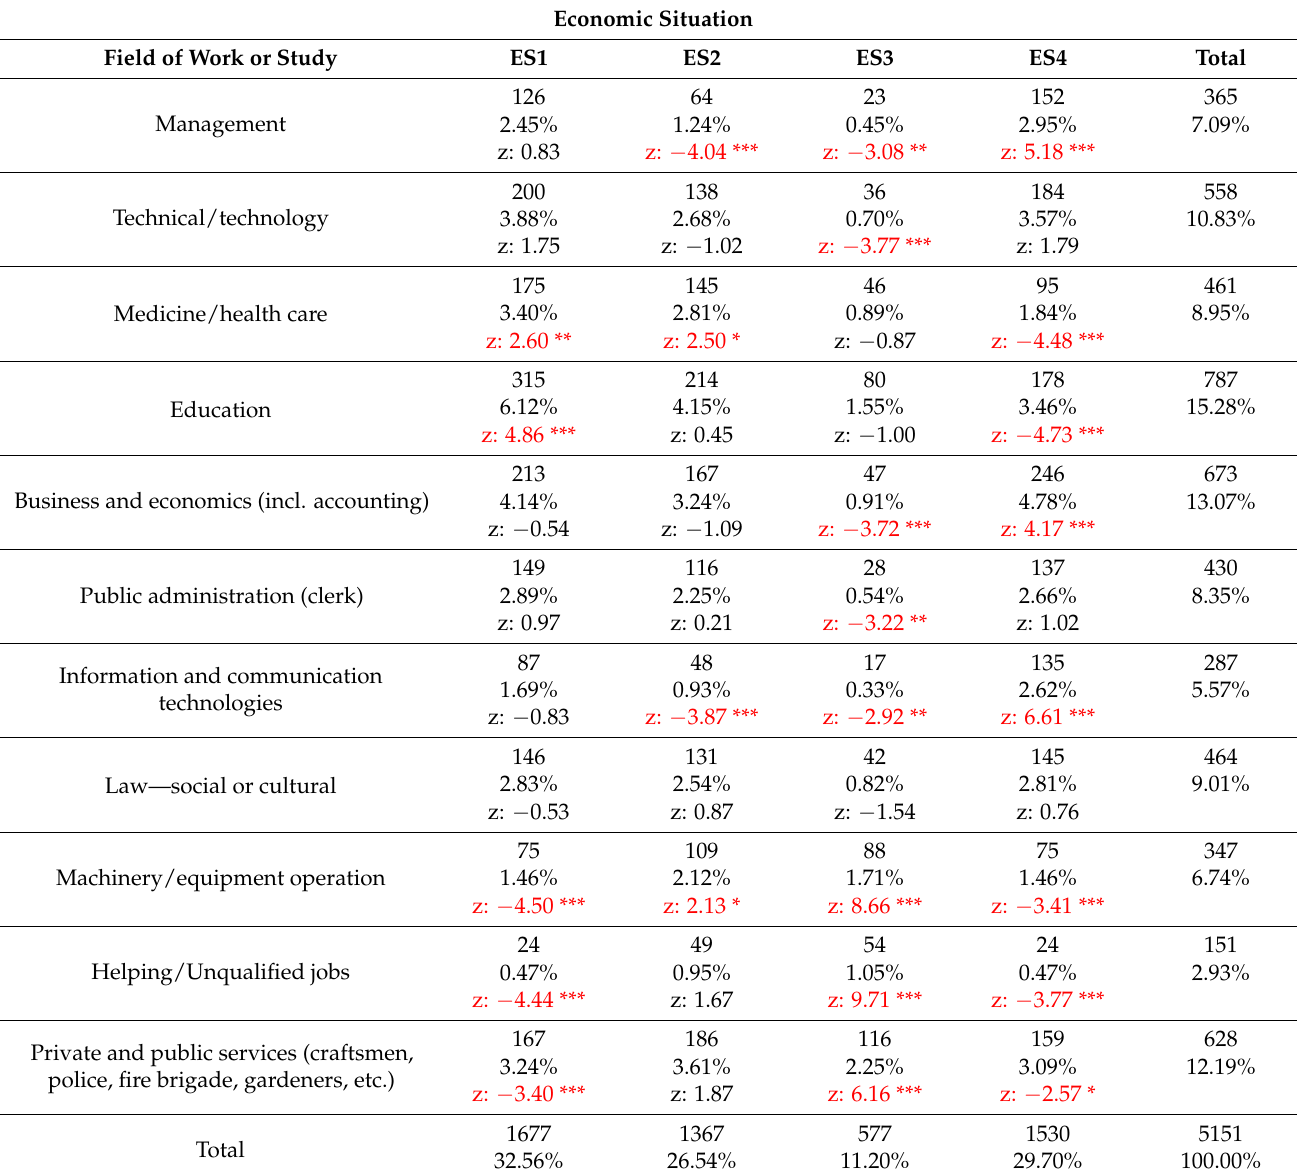
Table 5. Economic situation’s dependence on field of work or